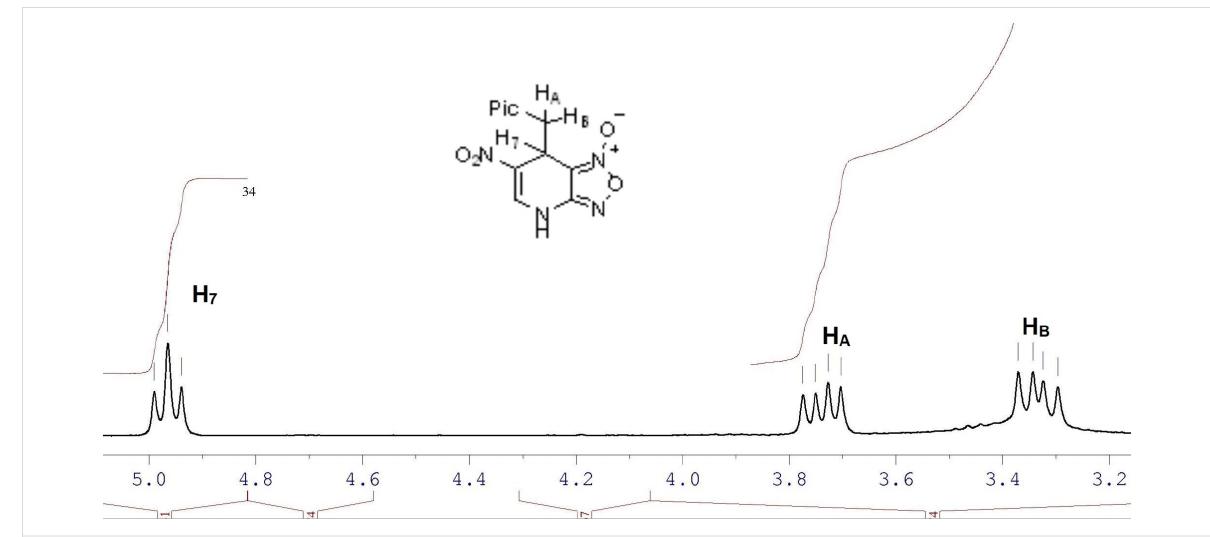
Figure 2: Partial 1 H NMR spectrum of compound 15 in DMSO- d 6 .